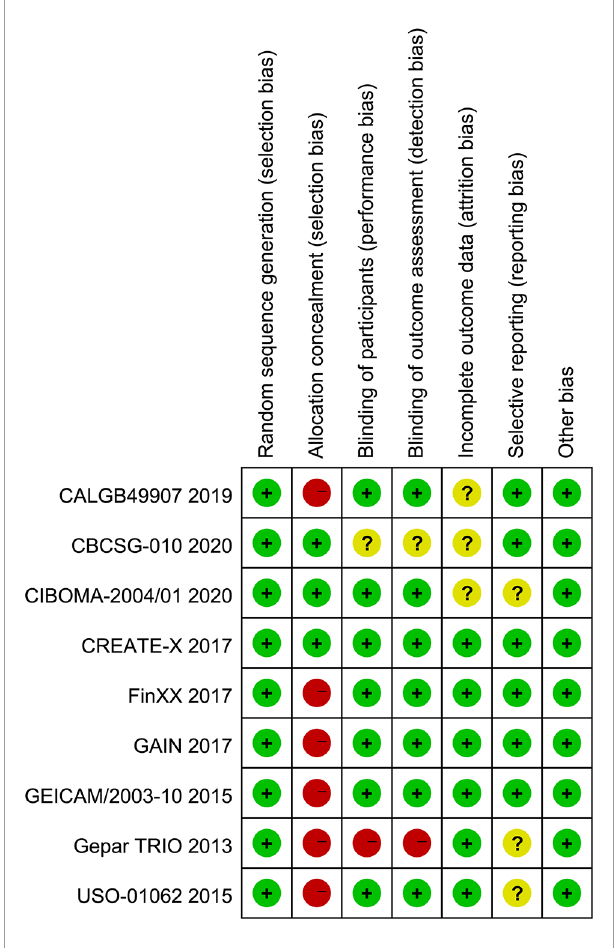
FIGURE 2 | Authors ’ judgments of each risk of bias item for eligible